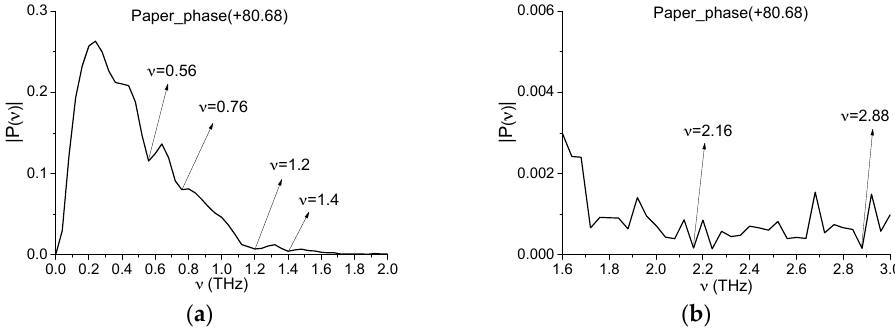
Figure 8. Fourier spectrum of the main pulse of the transmitted Paper_phase(+80.68) THz signal in the frequency ranges ν = [0, 2.0] THz ( a ) and ν = [1.6, 3.0] THz ( b ).